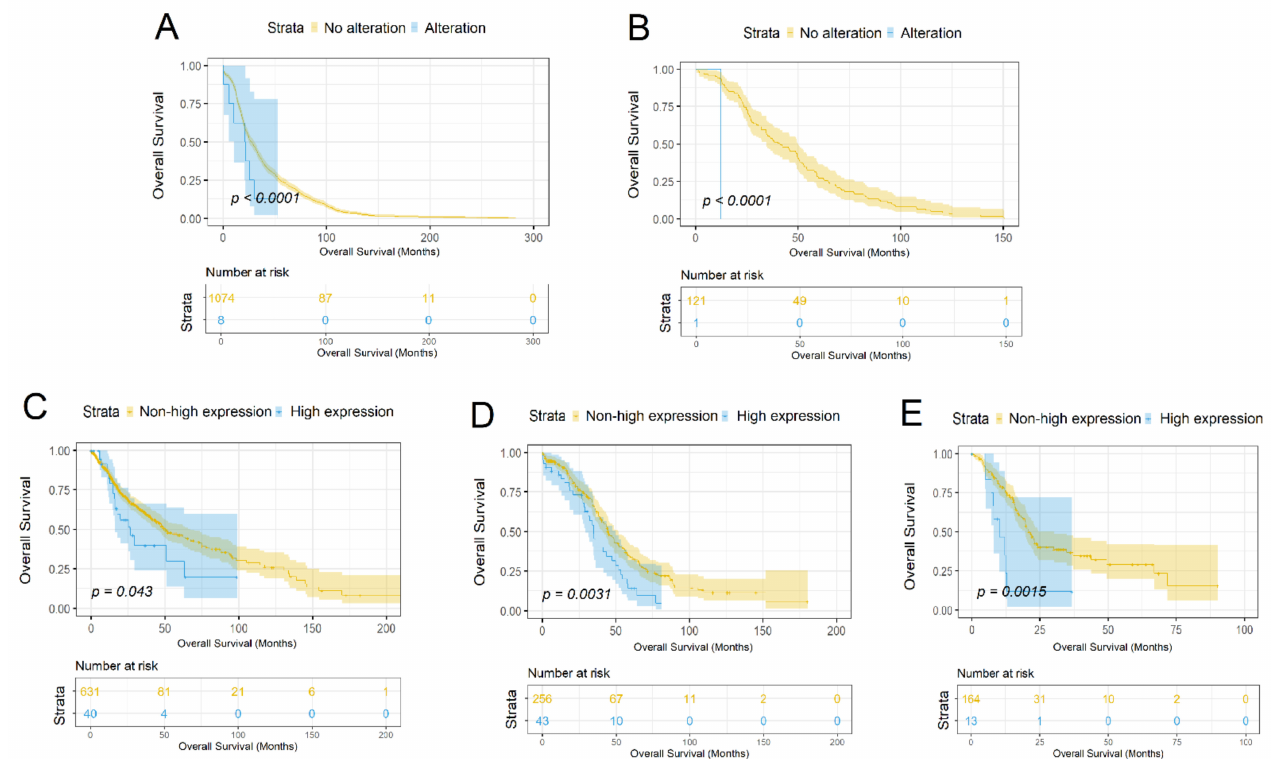
Figure 3. Survival analysis based on mutational and expression profiles of SLC34A2 (cBioPortal, TCGA; Kaplan–Meier estimator, p < 0.05). The tumor samples were divided into groups according to the presence or absence of SLC34A2 mutation: ( A ) breast: breast invasive carcinoma, n = 1082; ( B ) thymus: thymoma, n = 122. The tumor samples were divided into groups according to the level of SLC34A2 mRNA expression: ( C ) CNS and brain: brain lower grade glioma, n = 514; glioblastoma multiforme, n = 592; ( D ) ovary: ovarian serous cystadenocarcinoma, n = 299; ( E ) pancreas: pancreatic adenocarcinoma, n =